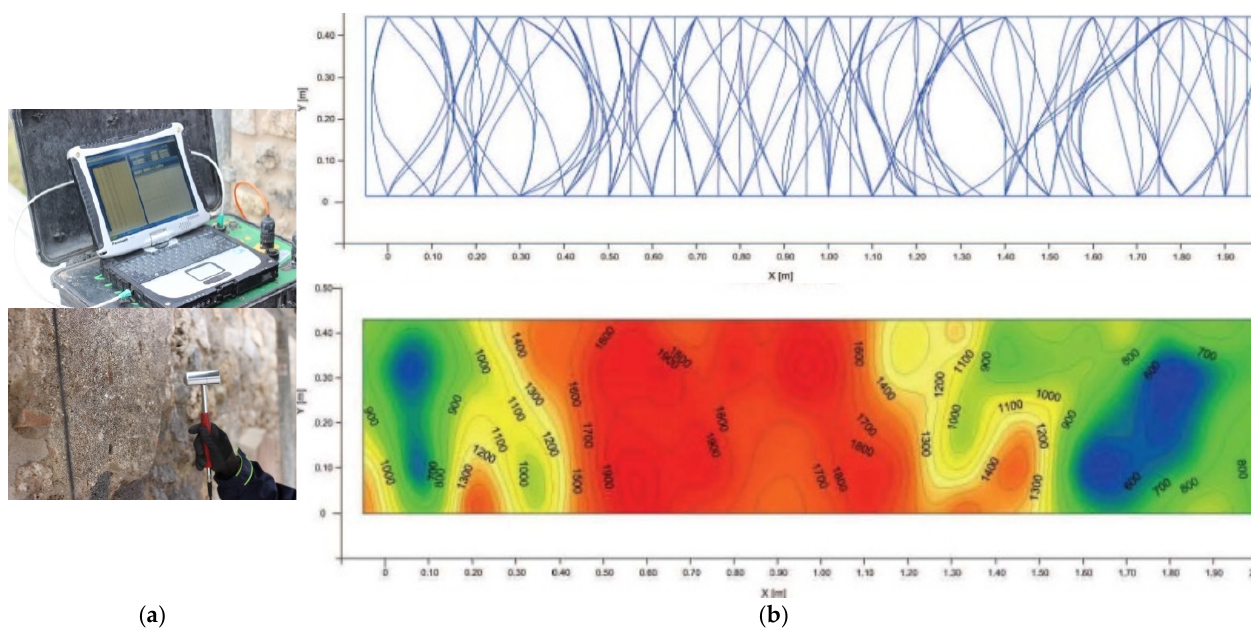
Figure 10. ( a ) Equipment for tomography tests. ( b ) Tomography test results on a plan section of an ancient wall.